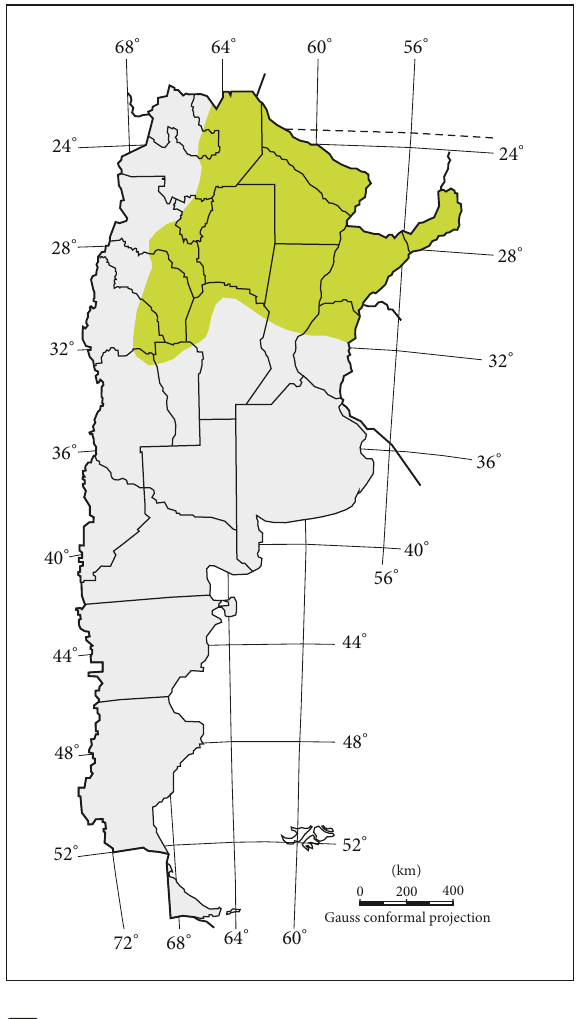
Figure 4: Annual mean maximum